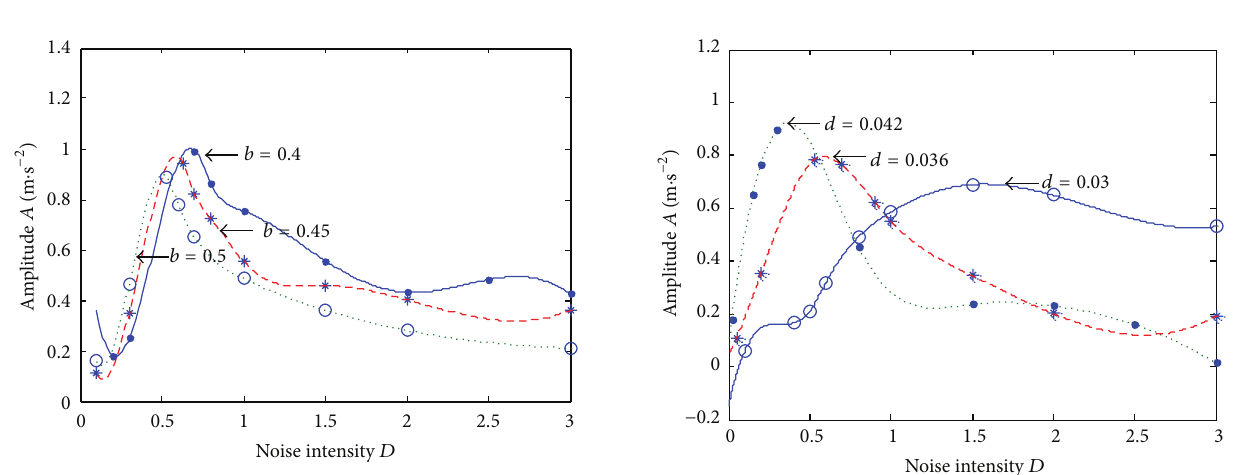
Figure 9: The variation curve of the output signal amplitude with the addition of noise 𝐷 under different 𝑑